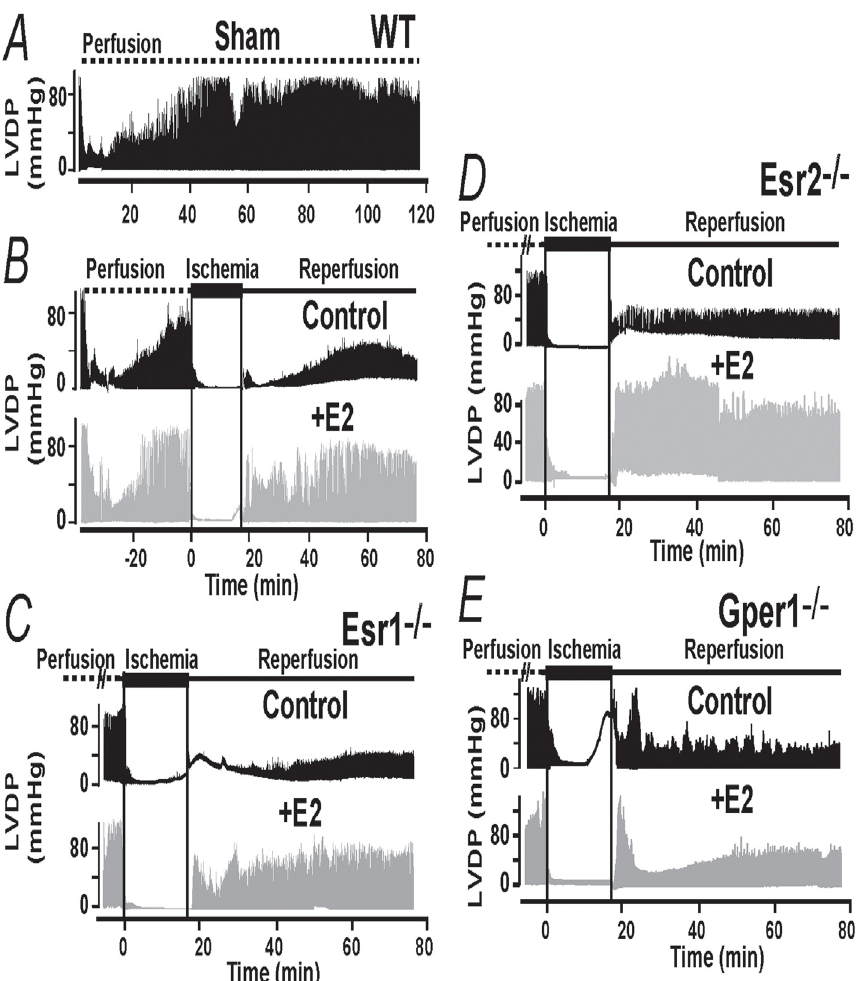
Fig 2. Gper1 activation is essential for E2-mediated cardioprotection. A. Recordings of left ventricular developed pressure (LVDP) comparing heart activity from wild-type (WT) animals not subjected to ischemia/ reperfusion (Sham) with the function of hearts subjected to the ischemia reperfusion (I/R) protocol under the continuous presence of vehicle (control) or 40 nM E2 in KH buffer. In sham hearts, function stabilizes at about 30 – 40 min after mounting and is stable for at least 2 hours. In hearts subjected to I/R (middle and bottom traces), E2 improved recovery from ischemia (during reperfusion) compared to control. B-D. LVDP traces from hearts of Esr1, Esr2 and Gper1 knockouts (-/-) subjected to I/R. Only in Gper1 -/- hearts, E2 lost its ability to improve functional recovery ( E ). n = 6 – 8 hearts/